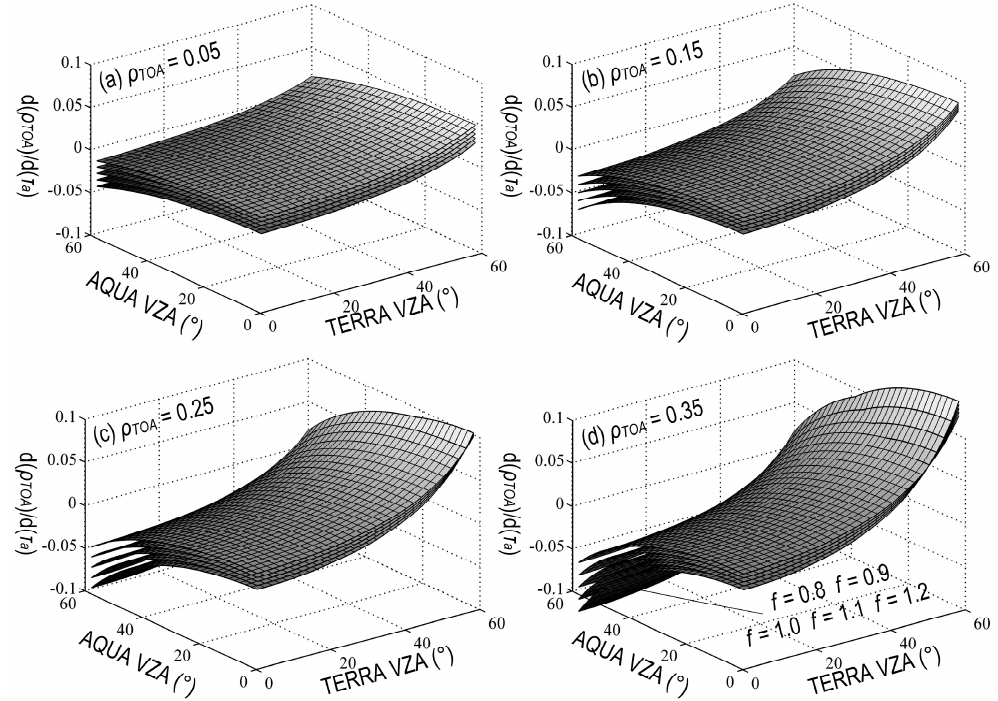
Figure 10. The effects of BRDF adjustment factor ( f BRDF = 0.8; 0.9; 1.0; 1.1; 1.2) on aerosol retrieval for ( a ) TOA reflectance = 0.05; ( b ) TOA reflectance = 0.15; ( c ) TOA reflectance = 0.25; and ( d ) TOA reflectance = 0.35.